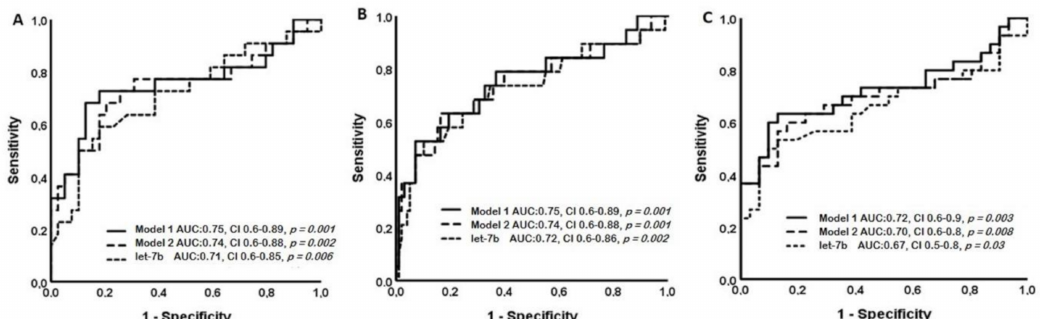
Figure 4. Impact of mRNA let-7b serum levels and calculated models in the outcome of renal function, as defined by fast progression ( A ), ESRD ( B ), and combined ≥ 50% reduction in eGFR and ESRD ( C